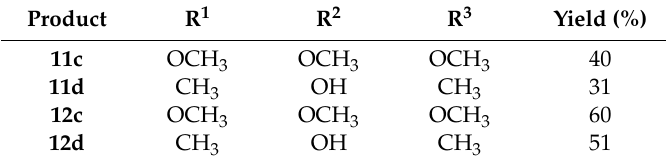
Table 3. List of cinchona-chalcone hybrids with 1,5-disubstituted-1,2,3-triazole linker and